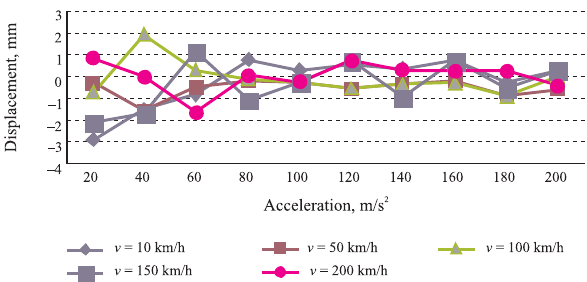
Fig. 8. Max stresses of the plate with different accelerations and fixed velocity